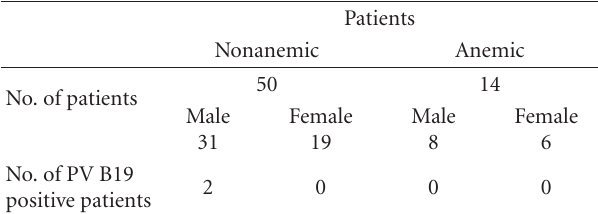
Table 1: Prevalence of Parvovirus B19 in kidney transplant recipients, from January to July 2008, Latina,